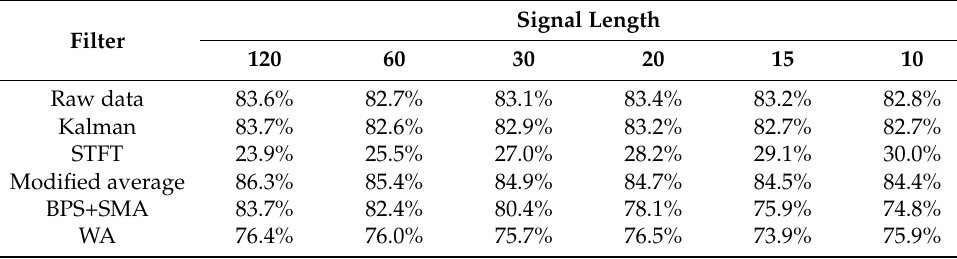
Table 2. Accuracy of computing using the difference between amplitudes for filtered PPG